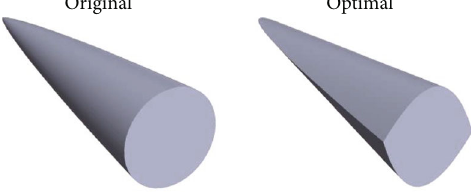
Figure 11: Original and optimal con fi gurations.